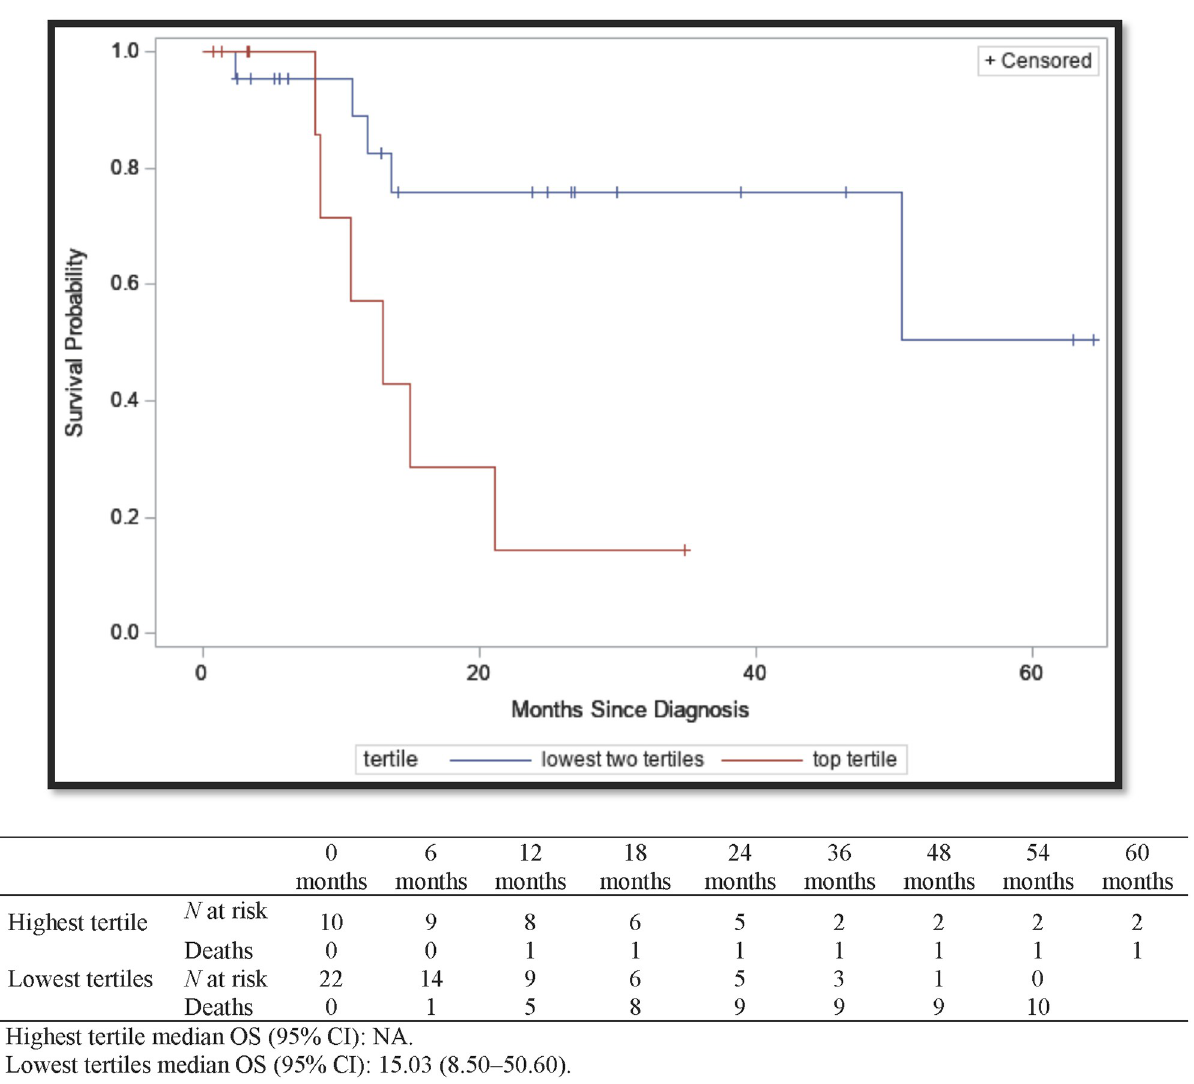
Fig 5. Kaplan-Meier survival curves for overall survival of MIBC by highest tertile of IFN- γ signature vs the lowest two tertiles. Mt Sinai Hospital System and North Shore Long Island Jewish Health System, New York, New York. 2004–2017. Highest tertile median OS (95% CI): NA. Lowest tertiles median OS (95% CI): 15.03